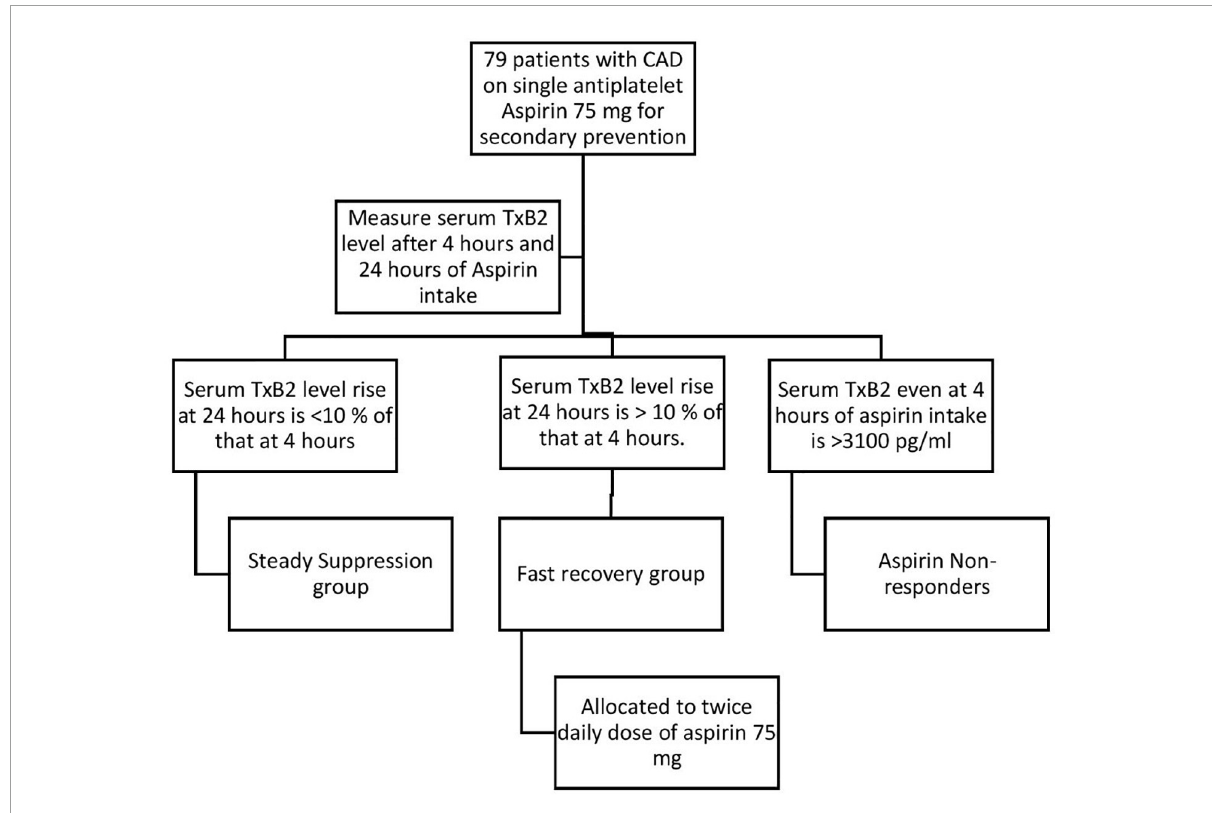
FIGURE1 Study design. Abbreviations: CAD, coronary artery disease; TxB2, thromboxane B2.